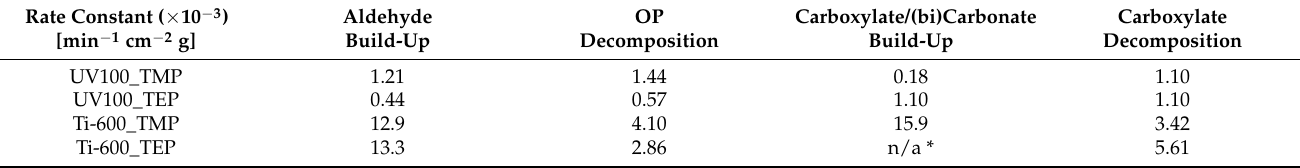
normalized by the specific surface area for each sample.